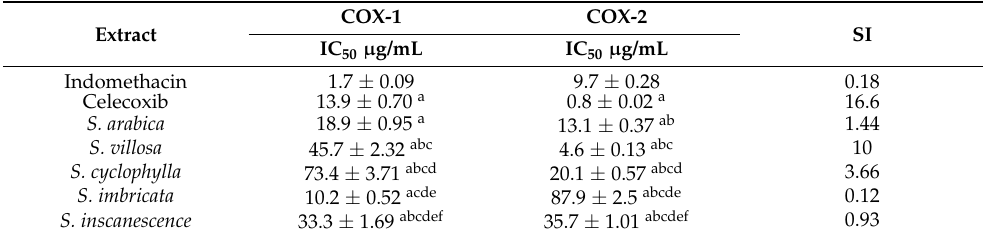
Table 2. Results of anti-inflammatory and antioxidant activity of n-hexane extracts of different Salsola